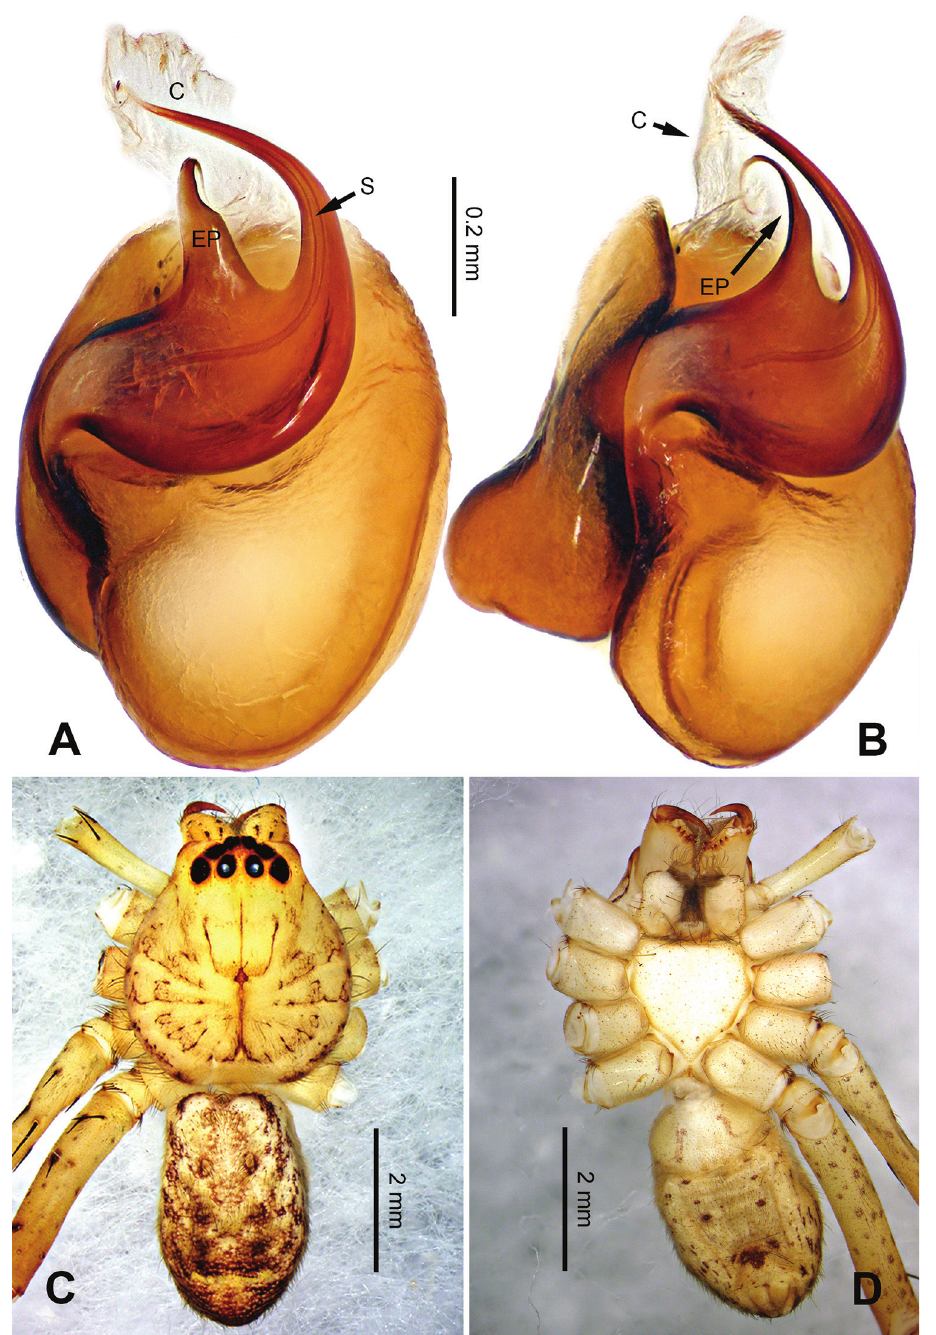
Figure 21. Pseudopoda shacunensis Zhao & Li, sp. n., male holotype. A Bulb, ventral view B Bulb, dorsal view C Habitus, dorsal view D Habitus, ventral view. Scale bar equal for A, B